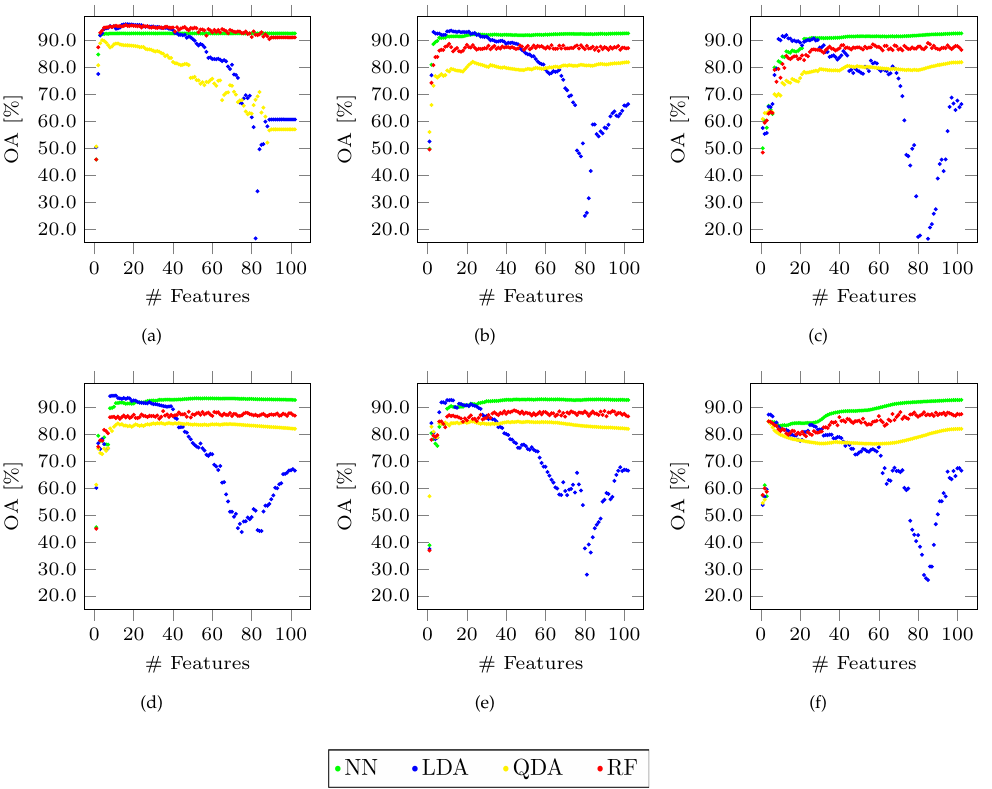
Figure 6. Classification results derived for the Pavia Centre dataset (9 classes) via sequential forward selection when using ( a ) the PCA; ( b ) the RF-MDPA; ( c ) the GRM; ( d ) the MUI; ( e ) the TUI and ( f ) the BOFR.